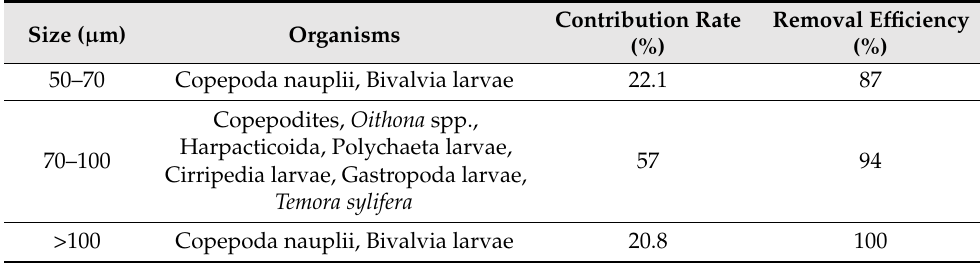
Figure 4. Removal efficiency of zooplankton species treated by GE BWMS pre-treatment system at each test cycle during pilot test period (R; removal efficiency). Table 6. Removal efficiency of zooplankton species treated by GE BWMS pre-treatment system according to the size different in the 1–8th test